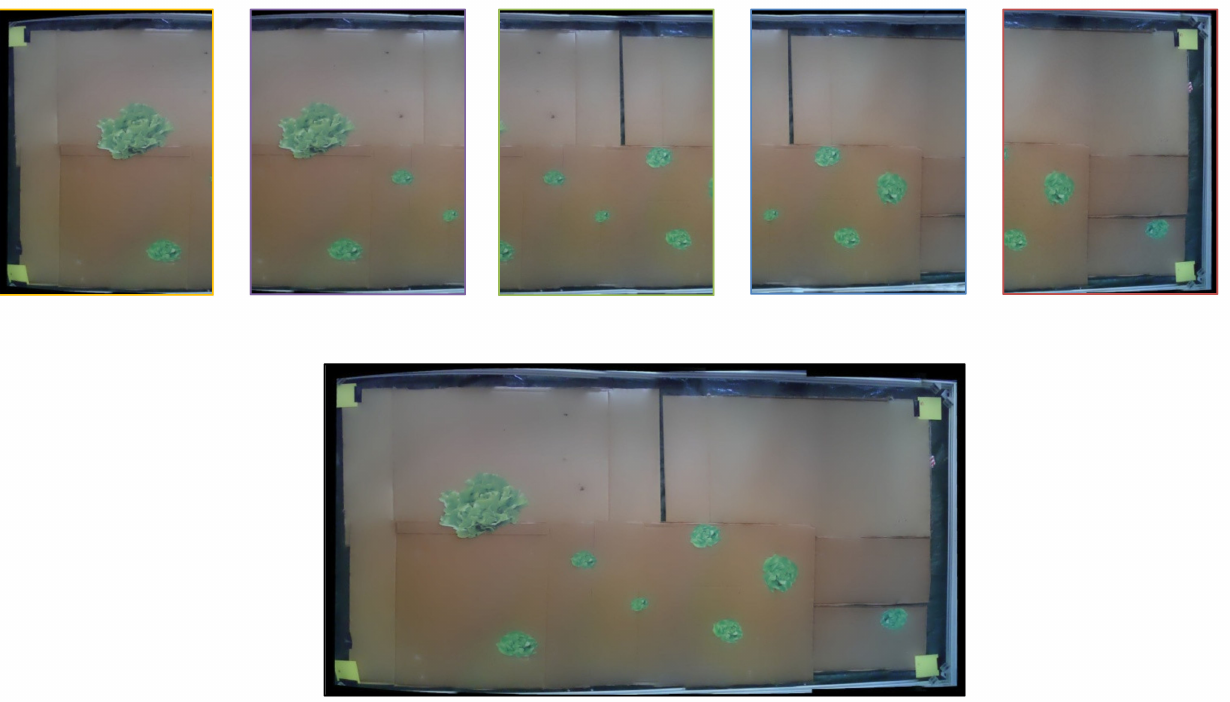
Figure 11. Image stitching example. Five separate images being combined into a single